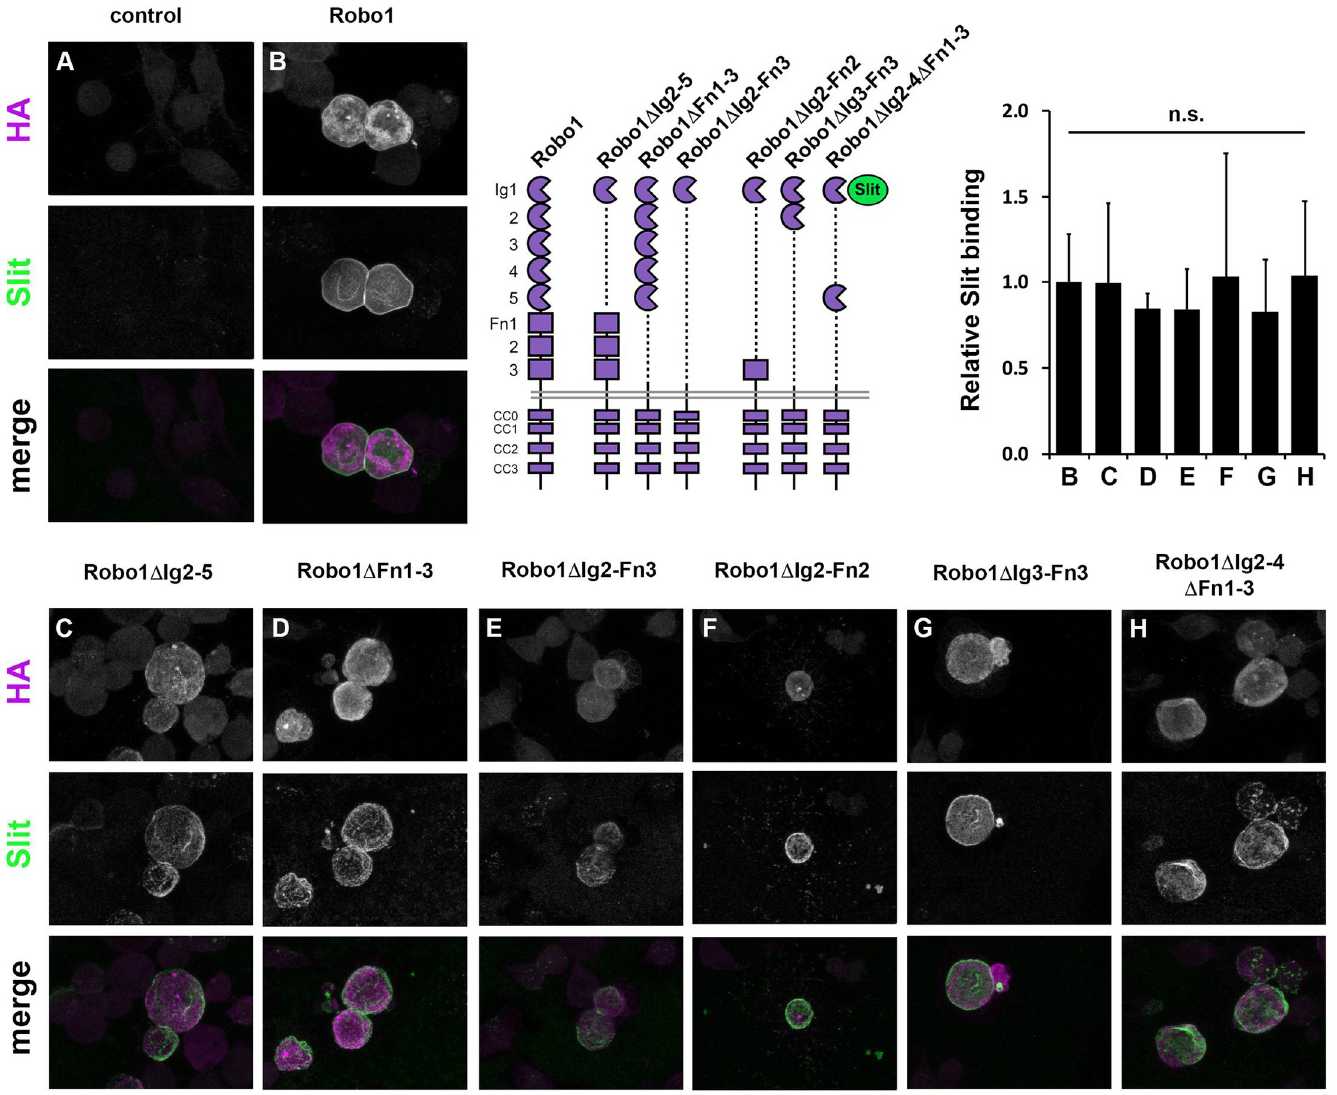
Fig 1. Robo1 variants containing an Ig1 domain can bind slit in vitro . Cultured Drosophila S2R+ cells expressing full-length Robo1 (B) or a version of Robo1 with elements of its ectodomain deleted (Robo1 Δ Ig2-5 C, Robo1 Δ Fn1-3 D, or Robo1 Δ Ig2-Fn3 E, Robo1 Δ Ig2-Fn2 F, Robo1 Δ Ig3-Fn3 G, Robo1 Δ Ig2-4Fn1-3 H) were treated with media containing Slit. After Slit treatment, Robo1-expressing cells were fixed and stained with antibodies to detect HA-tagged Robo1 (magenta), and Slit (green). Slit binds to cells expressing full-length Robo1 and deletion variants C-H, but does not bind to untransfected cells (A). Receptor schematics show full-length Robo1 and Robo1 variant deletion constructs. Bar graph quantifies Slit binding levels in conditions B-H, normalized to the level observed with full-length Robo1 (B). Error bars show s.d. No statistical difference in Slit binding was detected for any Robo1 variant (C-H) compared to full-length Robo1 by Student’s two-tailed t-test (p > 0.9 for all variants